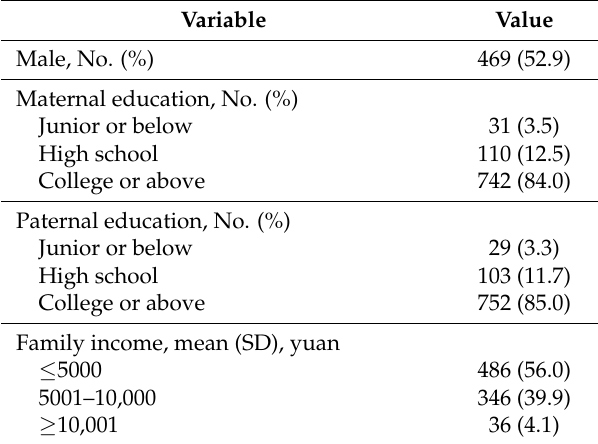
Table 1. Characteristics of the mother-child